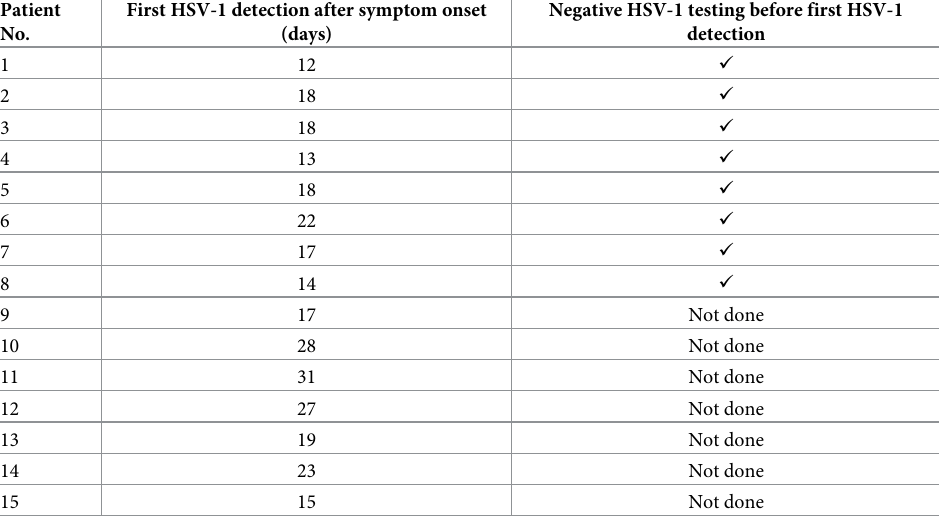
The expression of the interferon-stimulated genes (ISGs): IFI44L, MX1, RSAD2, ISIG15, and IFIT1 as well as IL-1b in peripheral blood was analyzed and shown as transcripts/1000 tran- scripts of the PPIB gene (Fig 6A–6F). The ISGs and additionally activated CD8 T-cells (CD38 +HLA-DR+) are presented before and after HSV-1 detection in respiratory specimens. A sig- nificant decrease was observed for FI44L, MX1, RSAD2, ISIG15, and IFIT1 (Fig 6B–6G) Table 3. HSV-1 testing in TS/BAL of study population. Patient